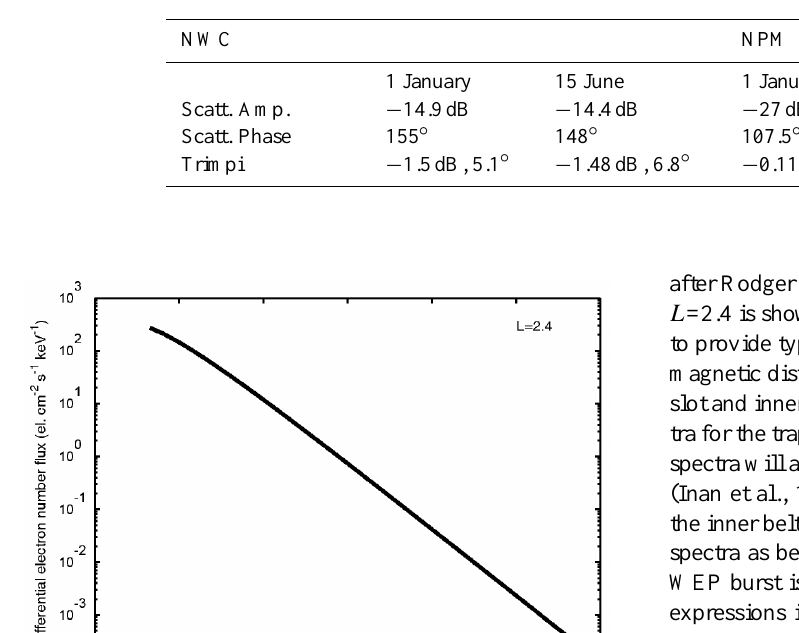
Table 1. Calculated scatter amplitude, scatter phase and absolute Trimpi size (amplitude and phase) calculated for the LIE shown in the lower panel of Fig. 2, on transmissions received at Dunedin.